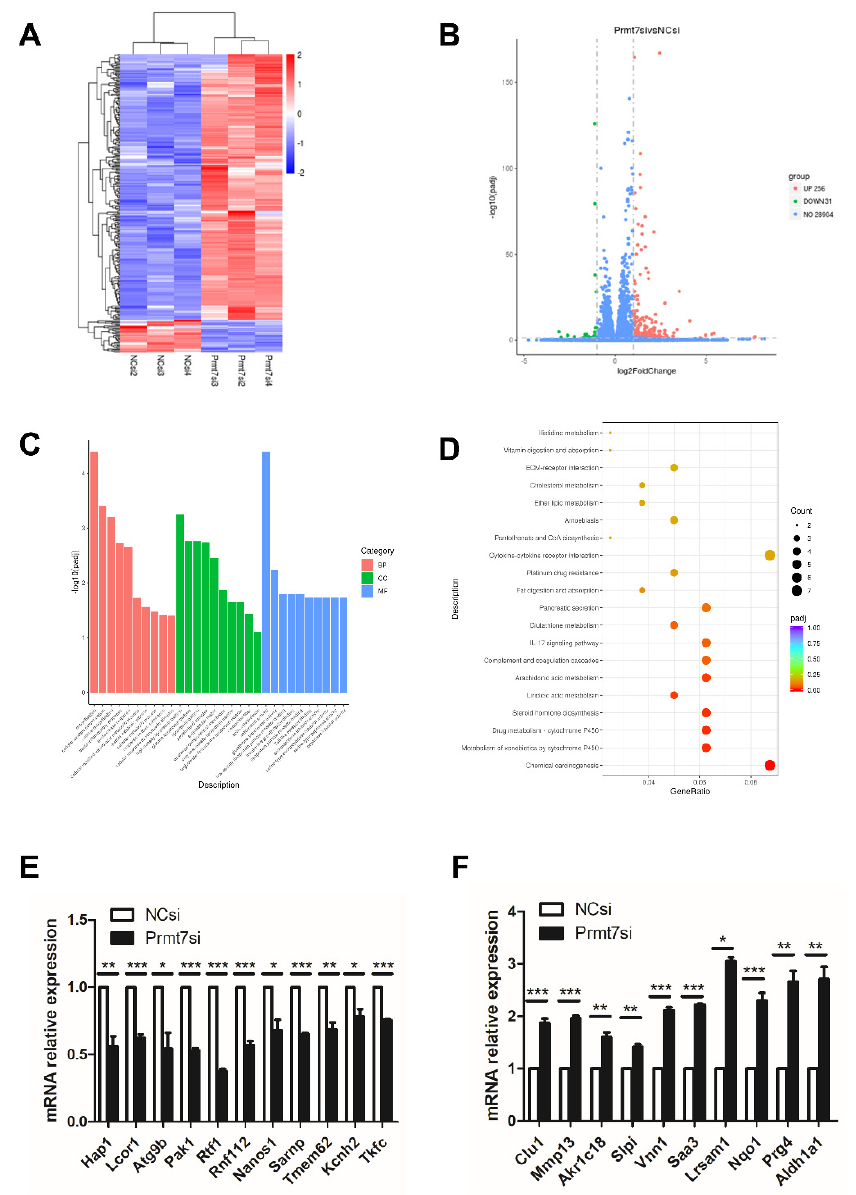
Figure 4. Transcriptome analysis (RNA sequencing) of spermatogonia transfected with NC and Prmt7 siRNA. ( A ) Clustered heatmap of differentially expressed genes (DEGs) with criteria of adjusted p < 0.05, |log2 fold change| > = 1 was constructed according to the RNA expression level. Two groups with respective three replicates were classified. Blue represents low relative expression of RNAs, and red represents high relative expression of RNAs. ( B ) The volcano plot of 256 upregulated DEGs and 31 downregulated DEGs in Prmt7si-transfected spermatogonia relative to NCsi-transfected spermatogonia was shown. ( C ) The top 10 terms of biological process (BP), cellular component (CC), and molecular function (MF) of all DEGs with GO functional enrichment analysis were shown. ( D ) Top 20 pathways of all DEGs with KEGG pathway enrichment analysis were shown. ( E ) Verification of randomly selected downregulated DEGs by RT-qPCR. ( F ) Verification of randomly selected upregulated DEGs by RT-qPCR. Data from three independent experiments are expressed as mean ± SEM. * indicates statistical significance. * p < 0.05, ** p < 0.01, and *** p < 0.001.